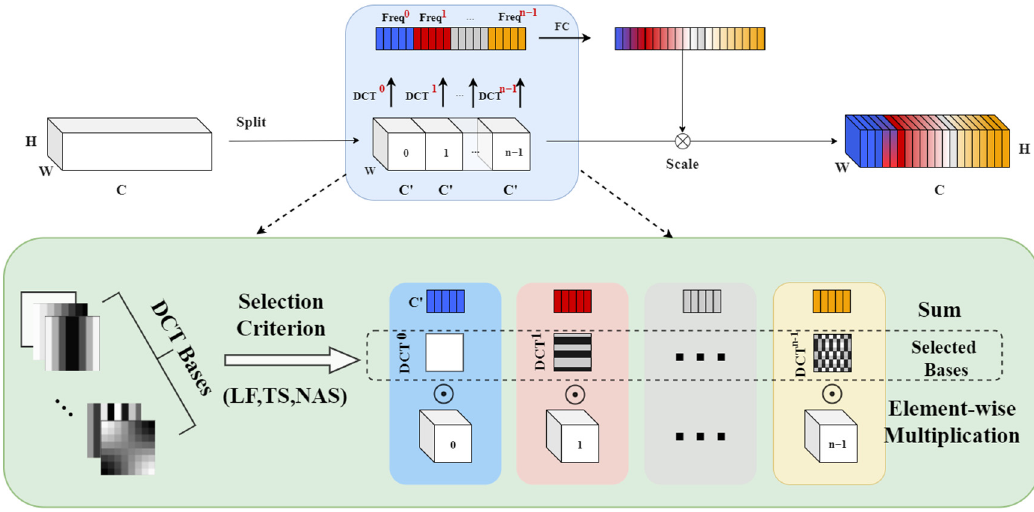
Figure 4. FCA Block.